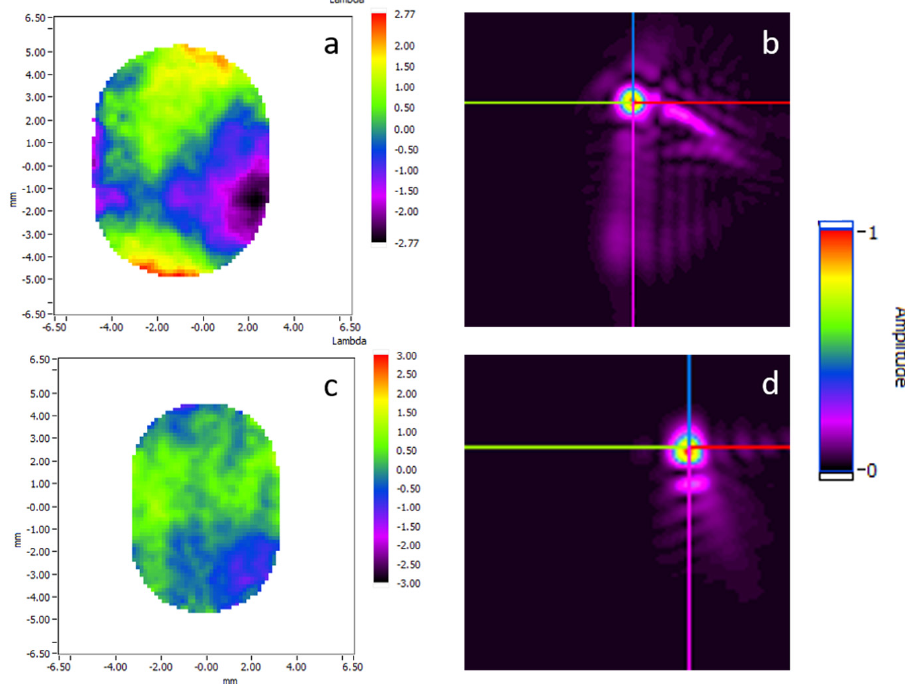
Figure 5. Wavefront maps before ( a ) and after ( c ) manual alignment of a Kirkpatrick-Baez. Energy distribution at the focal spot before ( b ) and after ( d ) alignment. Adapted with permission from [22].